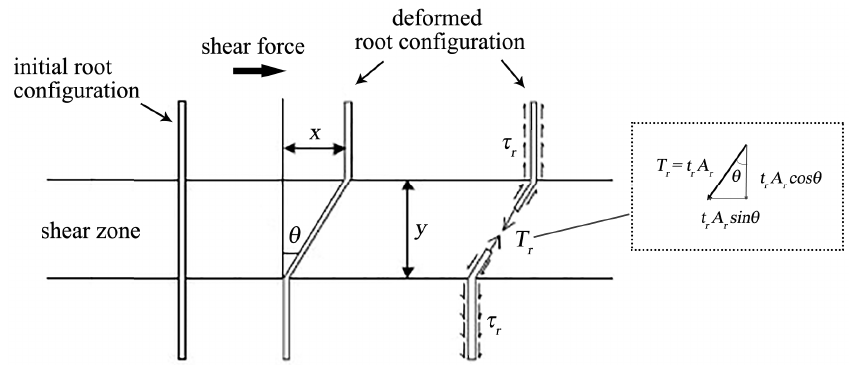
Figure 1. Soil–root interaction model (modified from